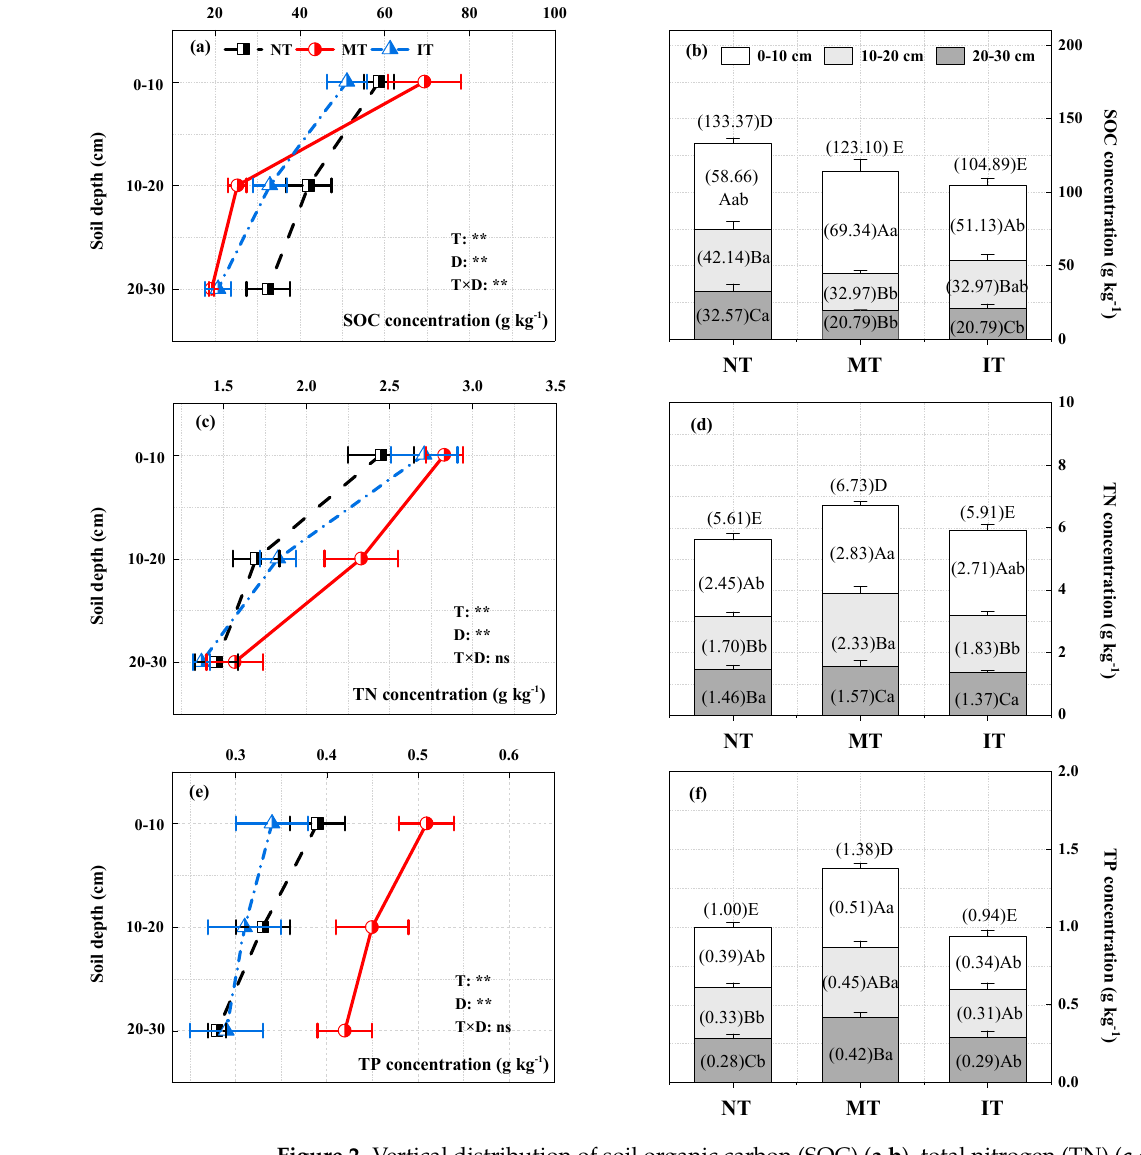
Figure 2. Vertical distribution of soil organic carbon (SOC) ( a , b ), total nitrogen (TN) ( c , d ), and total phosphorus (TP) ( e , f ) (mean ± SD, n = 3) in the 0–30 cm soil profile for the no-thinning control (NT), moderate thinning (MT), and heavy thinning (MT), respectively. Significant differences between thinning treatments (T), soil depths (D), and their interactions are shown at **, p < 0.01; and ns, p > 0.05. Different capital letters (A, B, and C) indicate significant differences between the same thinning treatment and different depths ( p < 0.05); different capital (D, E) and lowercase (a–c) letters indicate significant differences among different thinning treatments in the total soil profile (30 cm) and each 10 cm layer with corresponding soil layers ( p < 0.05), respectively.